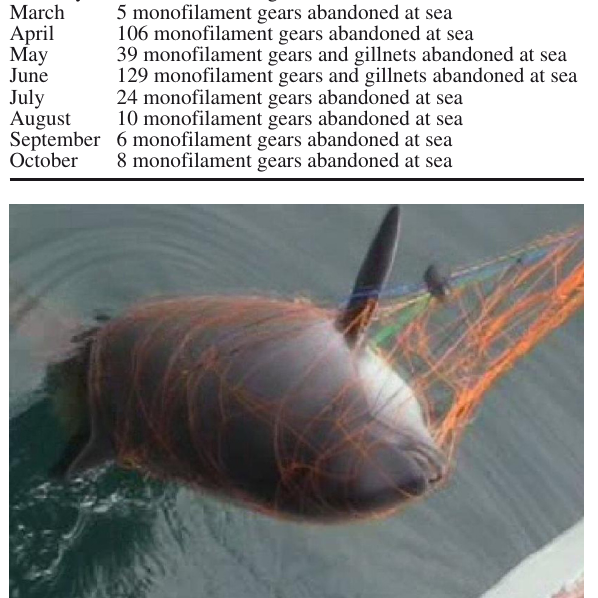
Fig. 5. – Cetaceans incidentally caught in gillnets.